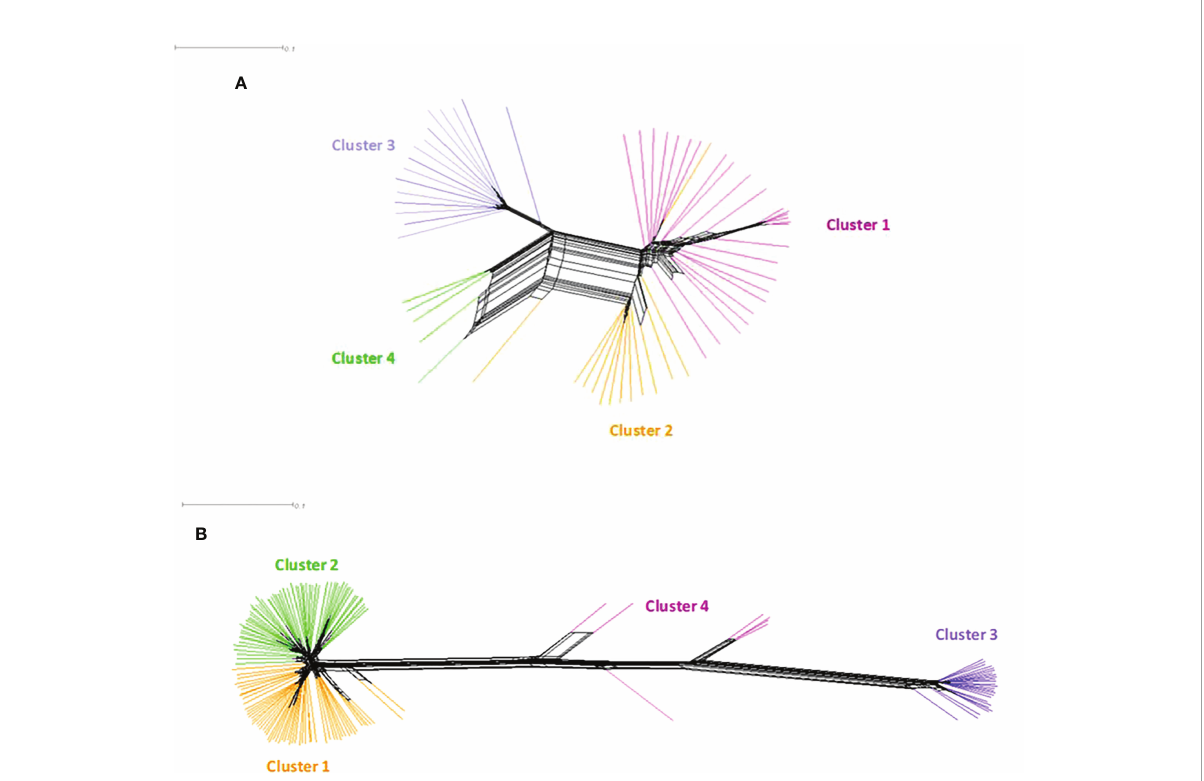
FIGURE 7 NeighborNet phylogenetic network of Bipolaris oryzae and Exserohilum rostratum isolates from Burkina Faso estimated with SPLITSTREE. (A) Bipolaris oryzae , (B) Exserohilum rostratum . Each color represents a genetic group previously de fi ned by DAPC. For Bipolaris oryzae , Cluster 1 is composed of 27 isolates (Bagre = 4, Bama = 3, Banfora = 5, Banzon = 8 and Sourou =7), Cluster 2 is composed of 13 isolates (Bagre = 4, Bama = 3, Banfora = 1, Banzon = 2 and Sourou =3), Cluster 3 is composed of 16 isolates (Bagre = 1, Bama = 4 and Sourou =11), Cluster 4 is composed of 5 isolates (Banfora = 5). For Exserohilum rostratum , Cluster 1 is composed of 58 isolates (Bagre = 38, Bama = 4, Banfora = 4, Banzon = 2 and Sourou =10), Cluster 2 is composed of 60 isolates (Bagre = 23, Bama = 4, Banfora = 7, Banzon = 2 and Sourou =24), Cluster 3 is composed of 26 isolates (Bagre = 5, Bama = 5, Banfora = 2 and Sourou =14) and Cluster 4 is composed of 7 isolates (Bagre = 3, Banzon = 1 and Sourou =